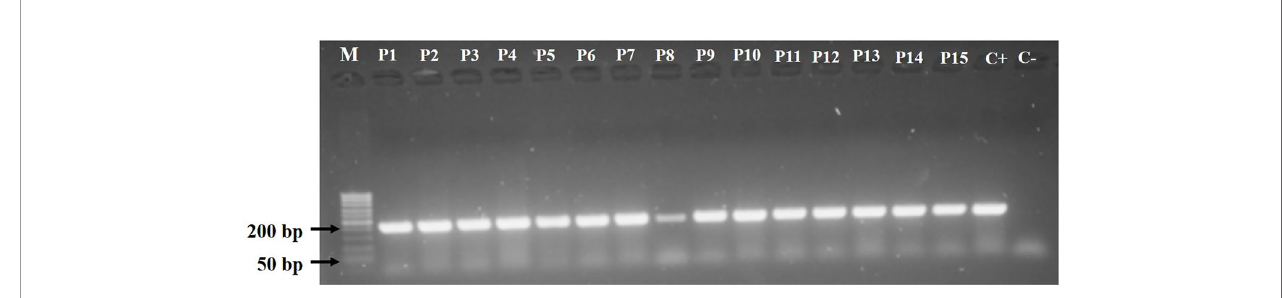
FIGURE 1 | Agarose gel electrophoresis (1.0%) of Pseudomonas aeruginosa isolates showing ampli fi ed PCR products for the oprL gene (209 bp). Lane 1 (M), molecular weight marker; P1 – P5, environmental isolates; P6 – P10, clinical isolates obtained from non-cystic fi brosis patients; P11 – P15, clinical isolates obtained from cystic fi brosis